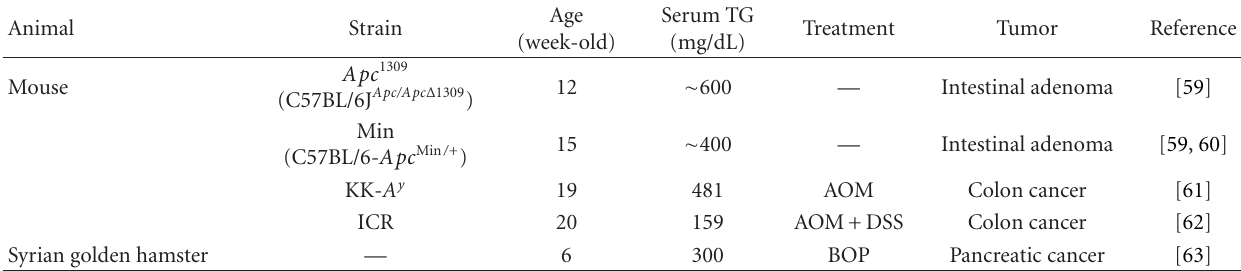
Table 1: Summary of animal models with dyslipidemia and cancer high susceptibility. Animal